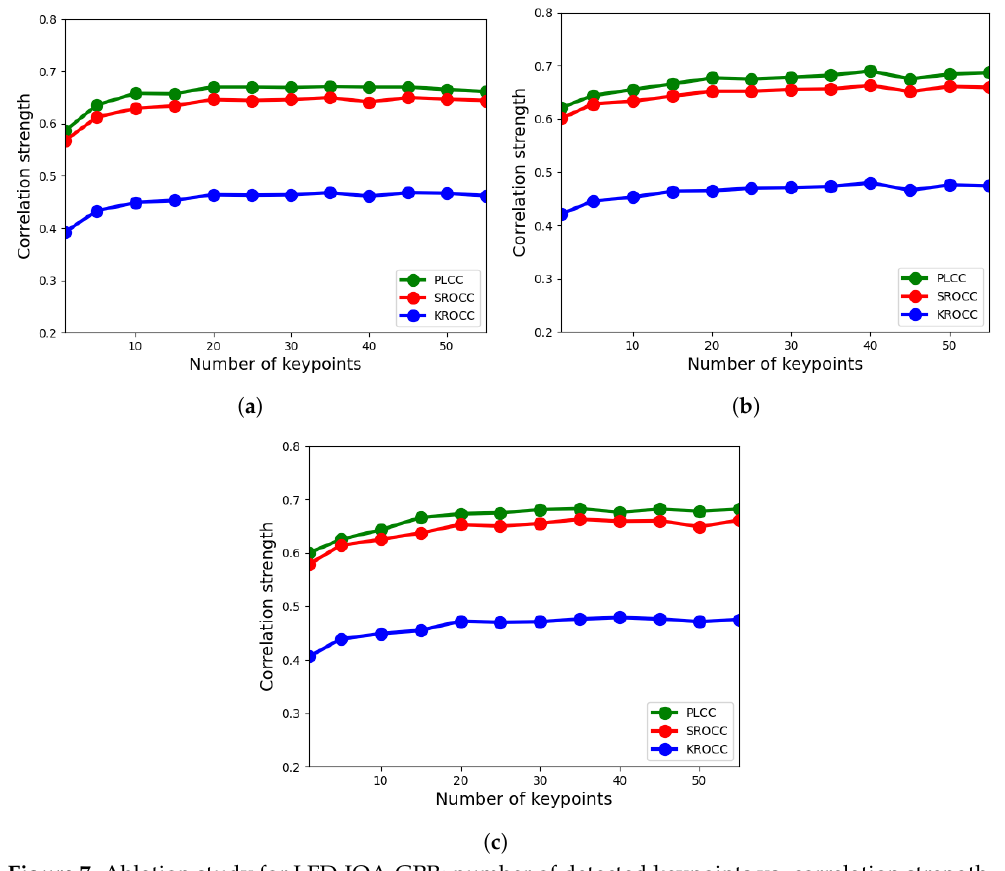
Figure 7. Ablation study for LFD-IQA-GPR: number of detected keypoints vs. correlation strength. ( a ) 3 × 3 block size, ( b ) 5 × 5 block size, ( c ) 7 × 7 block